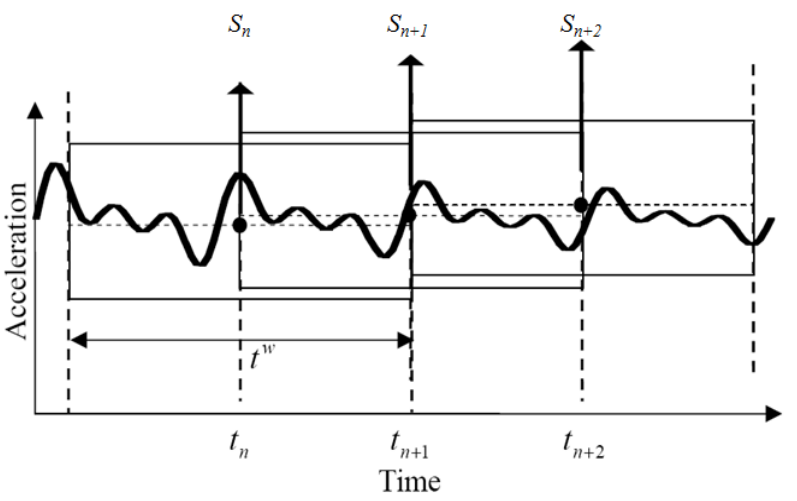
Figure 3. Time windowing technique